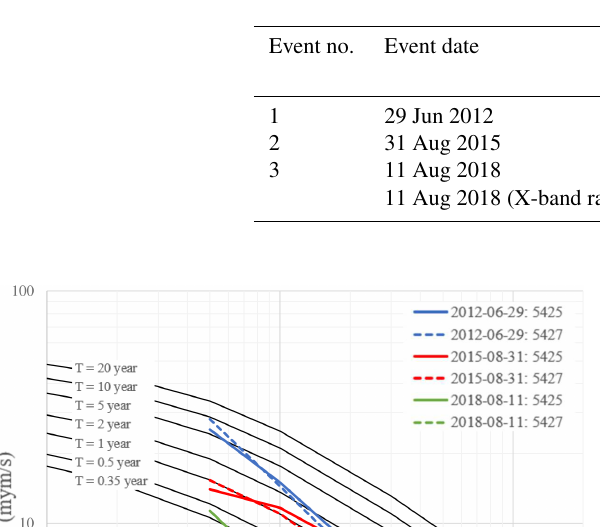
Table 4. Chosen events and their characteristics.